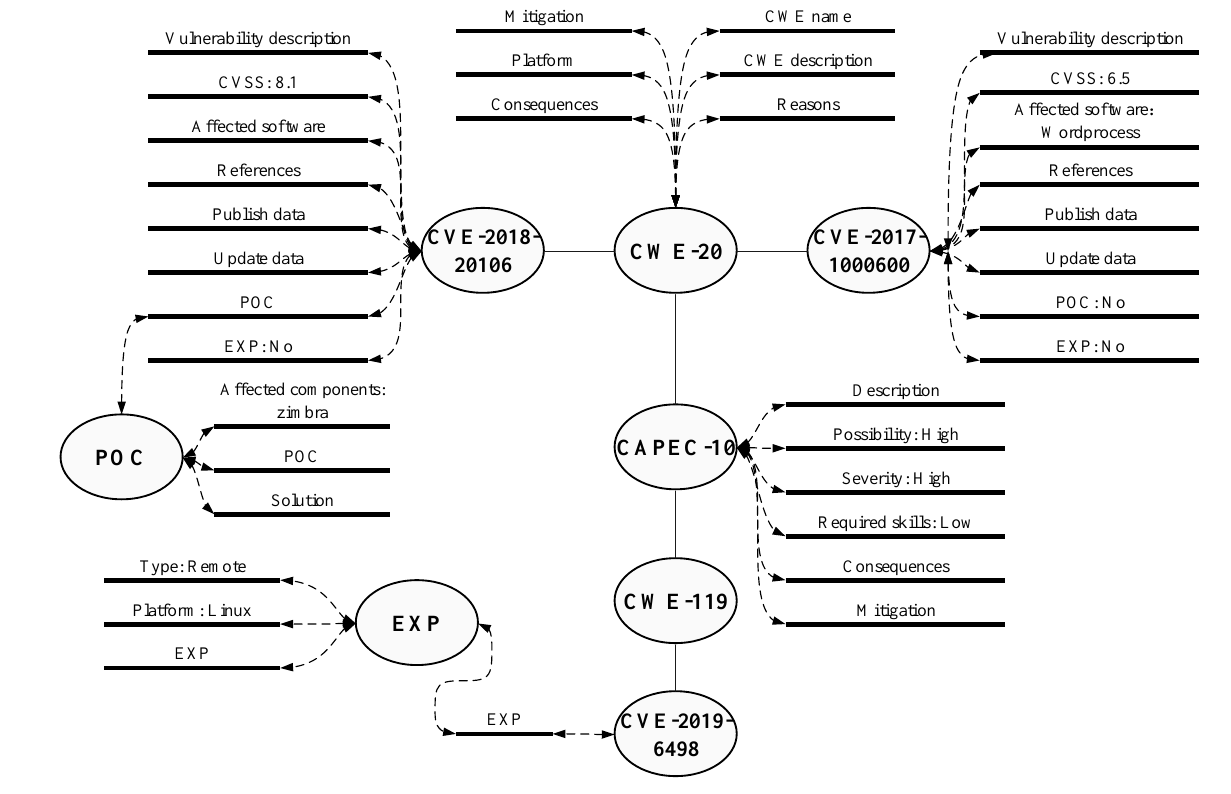
Figure 5. Vulnerability knowledge graph description. Table 7. Sources of vulnerability information